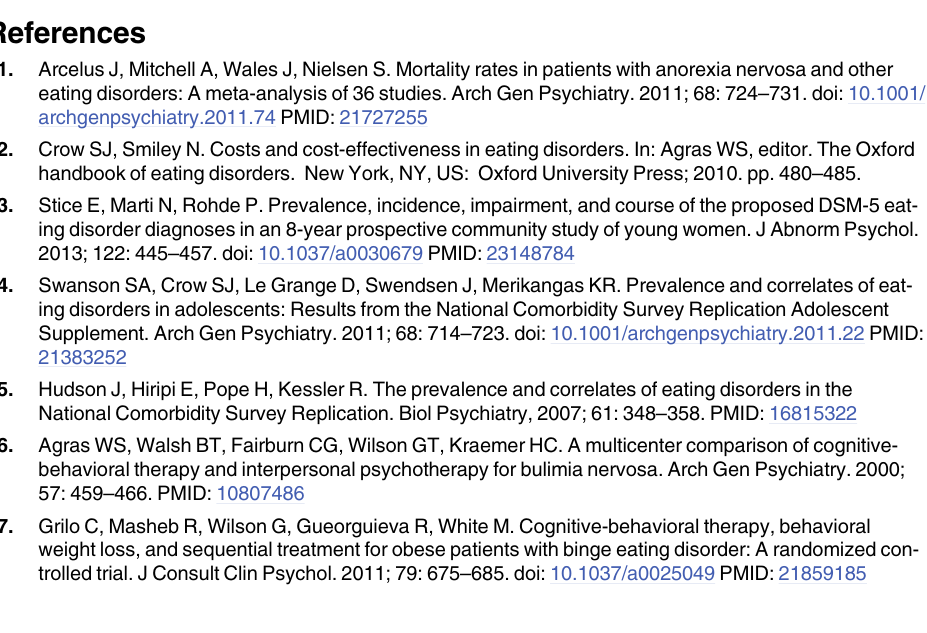
S2 Table. Within-group comparisons for the control group (n = 22) at pretest and posttest contrasting 2 thin-ideal models versus 2 average-weight models in the thin-ideal paradigm. S3 Table. Between-group comparisons at pretest in the thin-ideal paradigm. (DOCX) S1 Fig. Cortical activations in the intervention group (n = 16) plotting voxels more active during viewing two thin-ideal models compared to viewing two average-weight models at A) pretest and B) posttest. S2 Fig. Cortical activations in the control group (n = 22) plotting voxels more active during viewing two thin-ideal models compared to viewing two average-weight models at A) pre- test and B)